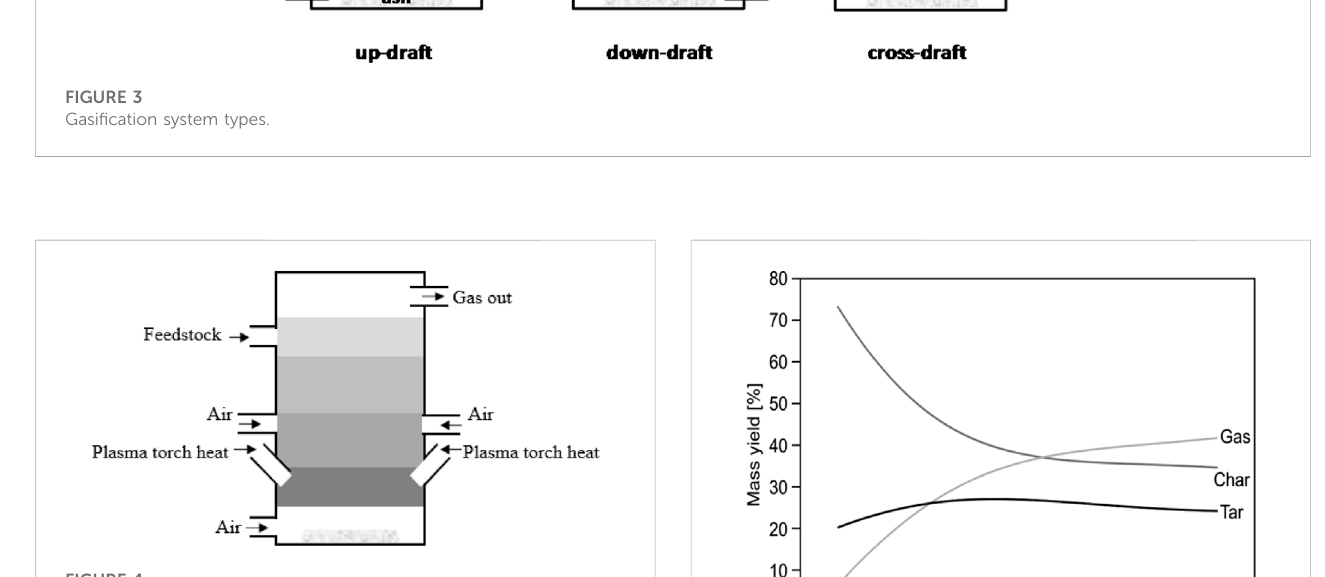
FIGURE 4 Plasma gasi fi cation (Oliveira et al. 2022).